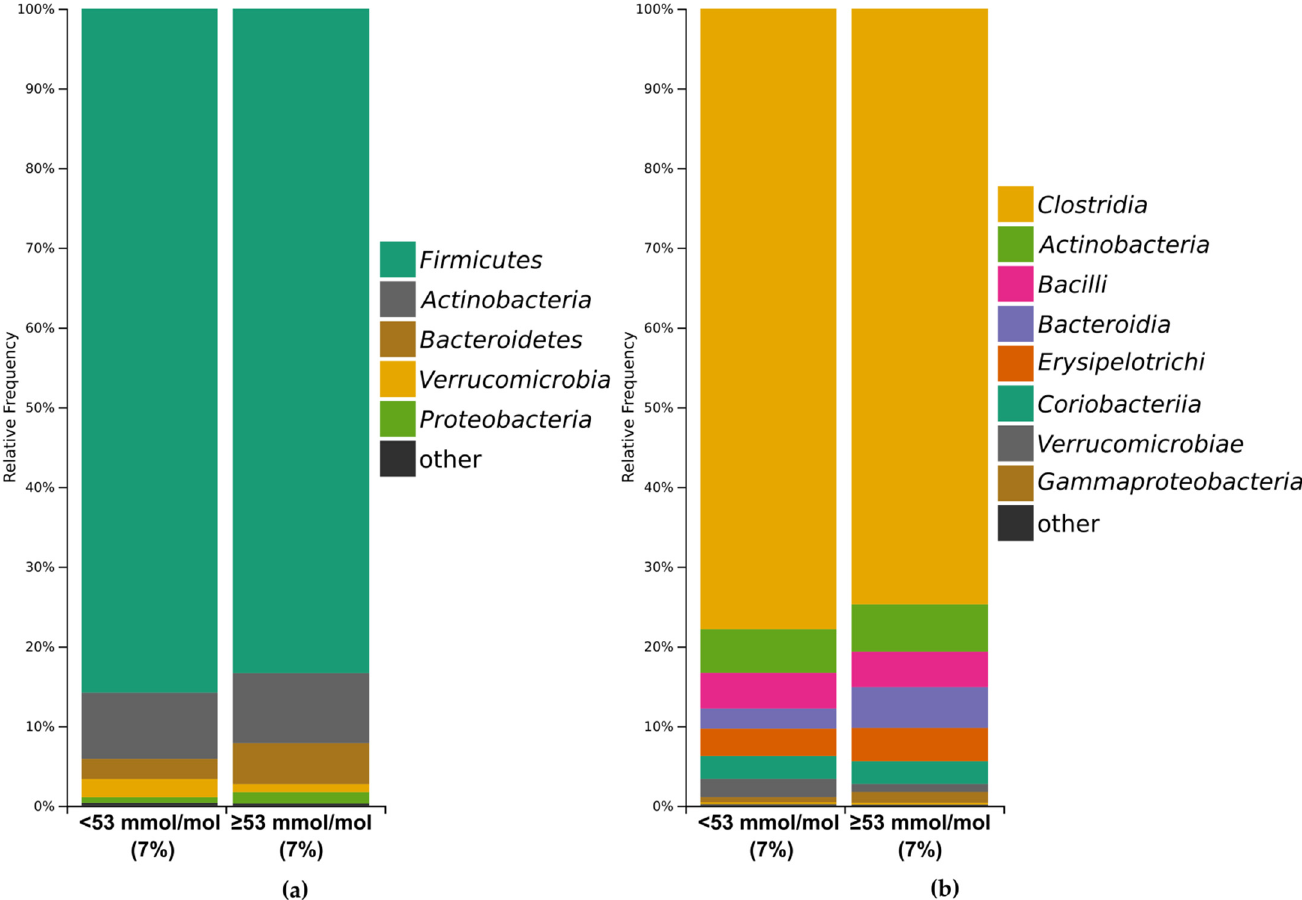
Figure 3. Relative abundance of most common bacterial phyla ( a ) and classes ( b ) at each group. All taxa with abundance below 1% are represented as ‘other.’